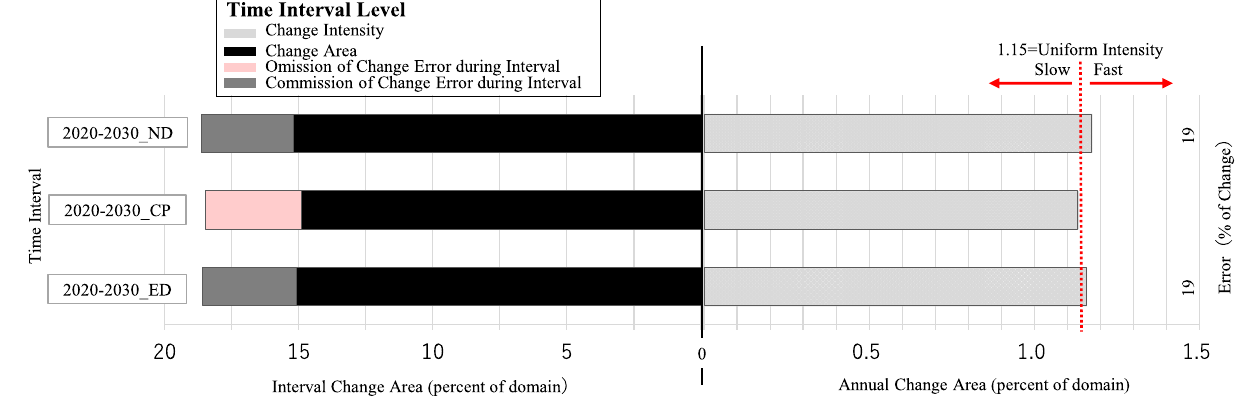
Fig.12 Foshan City’s land use in 2030 for multiple